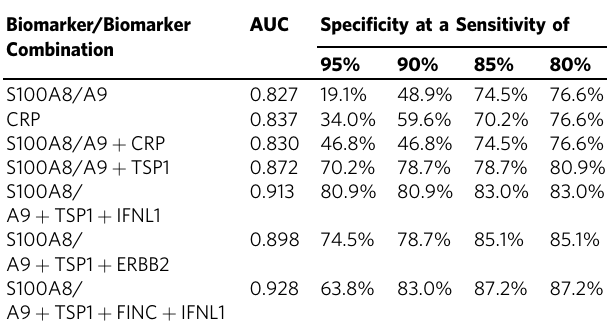
Table 3 Speci fi cities at given sensitivities for selected individual biomarkers and biomarker